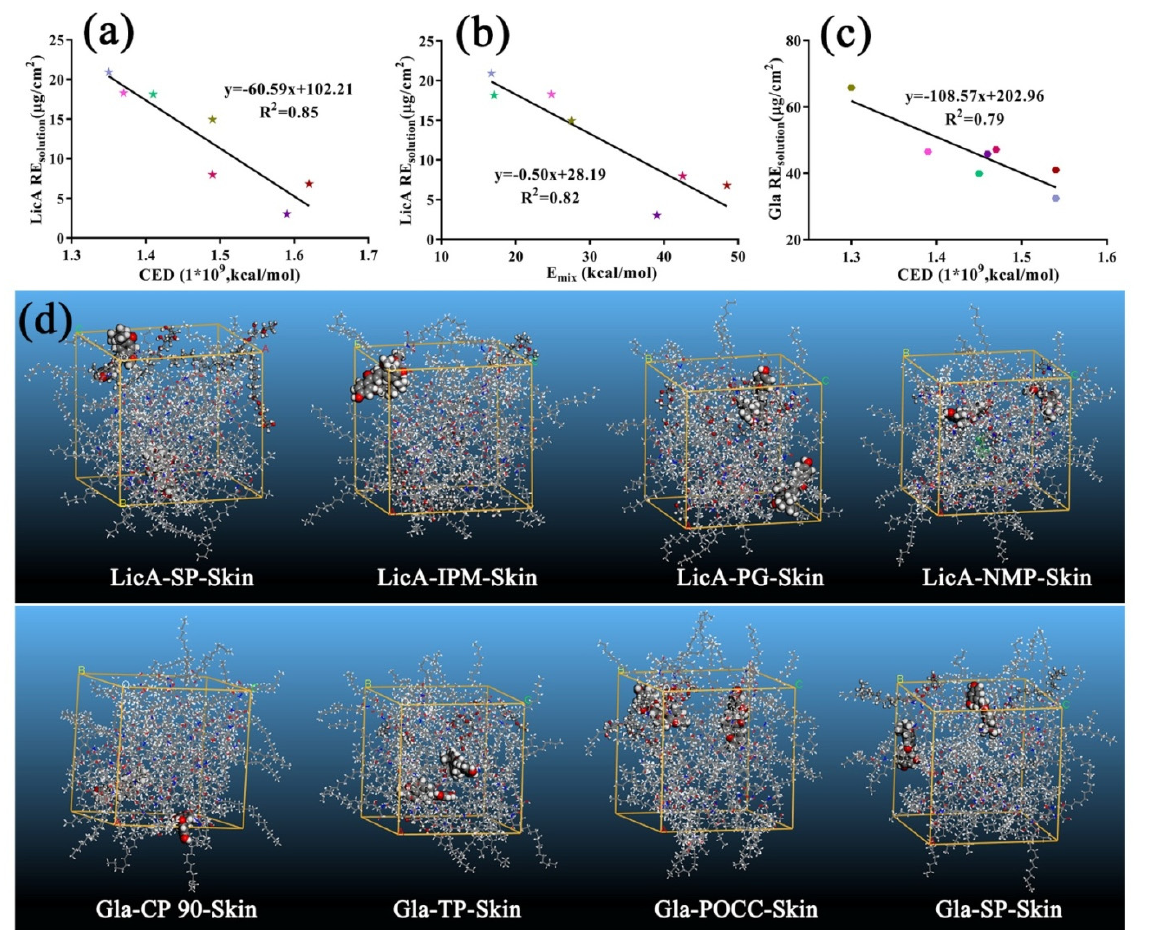
Figure 8. ( a ) Correlation analysis between LicARE solution and CED of ternary systems; ( b ) correlation analysis between LicARE solution and E mix of ternary systems; ( c ) the correlation relationship between GlaRE solution and CED of ternary systems; ( d ) snapshots of LicA(Gla)–enhancers–skin systems at the end of the MD (drug: ball and stick model; enhancers: CPK model).